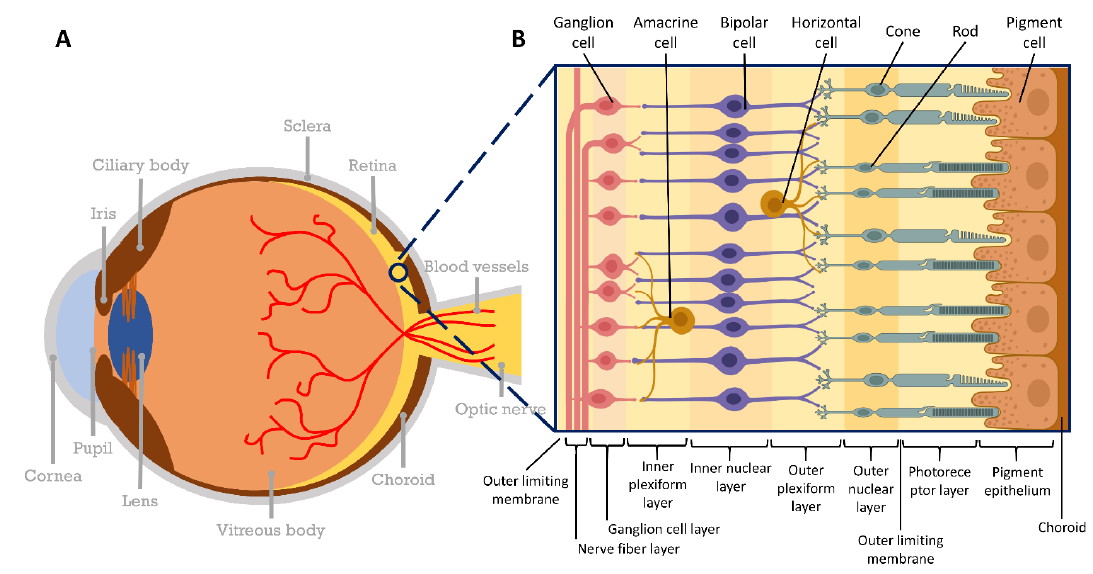
Figure 1. Structure of the eye and retina. ( A ) Structure of the eyeball consists of the cornea, lens, iris, macula, retina, and optic nerve that transmits visual information from the retina to the brain. ( B ) Cellular unit of the retinal layer. This figure was created using PowerPoint & BioRender (Available online: http://biorender.com (accessed on 9 April 2020)).